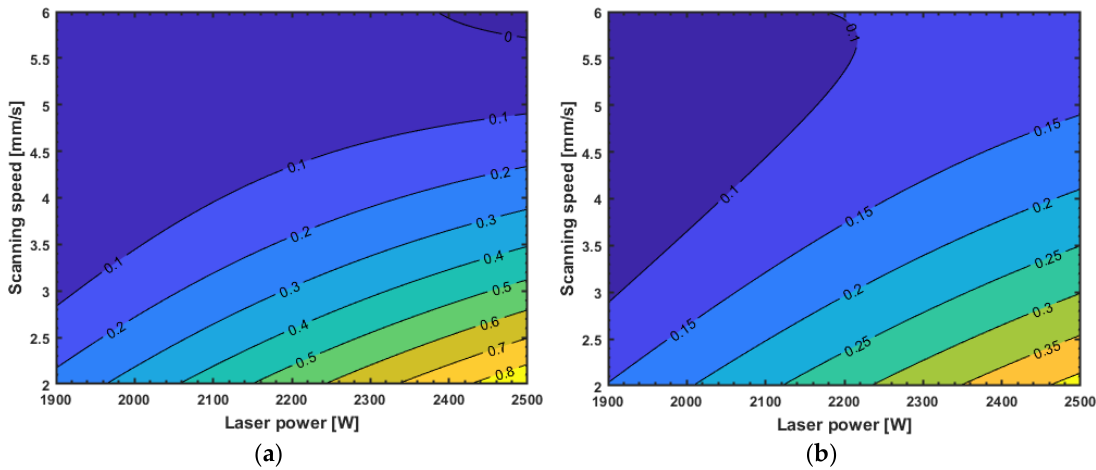
Figure 8. Contour plot of case depth [mm] versus power, scanning speed and rotation speed (1875 rpm) for the flank tilt angle of 15°: ( a ) at the tip of spline s’ tooth (H T ), ( b ) at the root of spline s’ tooth (H R ).